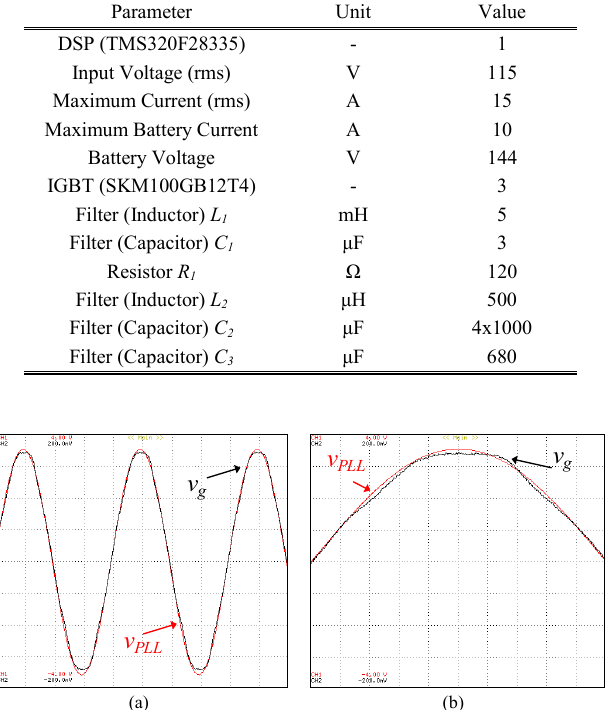
Figure 4. Experimental results: (a) Synchronism of the PLL signal ( v PLL ) with the power grid voltage ( v g ); (b) Detail of both